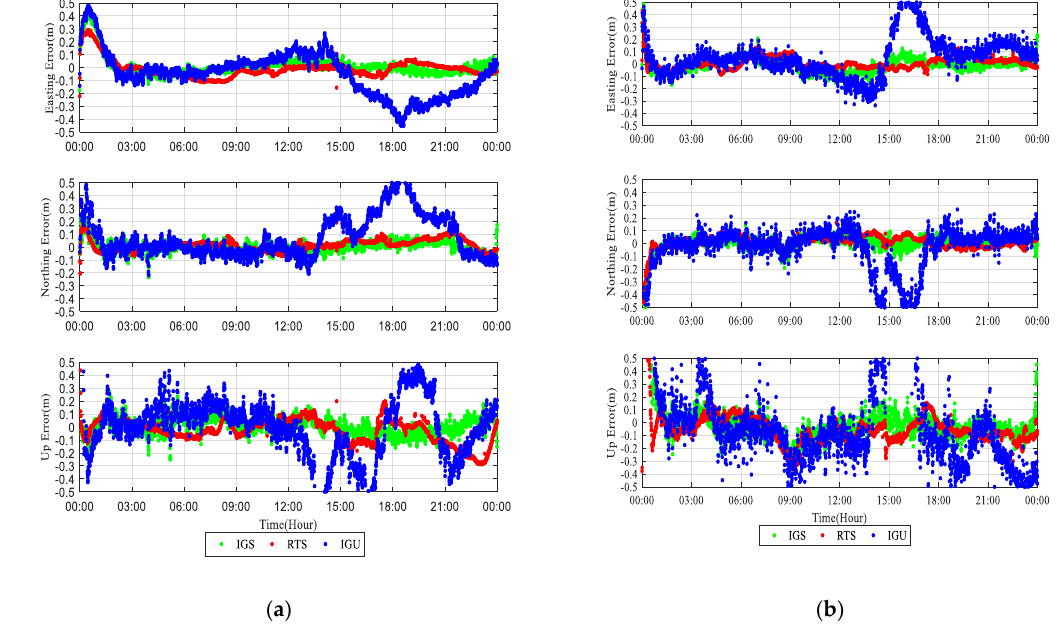
Figure 6. Kinematic precise point positioning (PPP) solutions using the RTS products (red), the IGS ultra-rapid (IGU) products (blue) and the IGS products (green) at station KOS1 ( a ) and SHAO ( b ) on October 19, 2017.